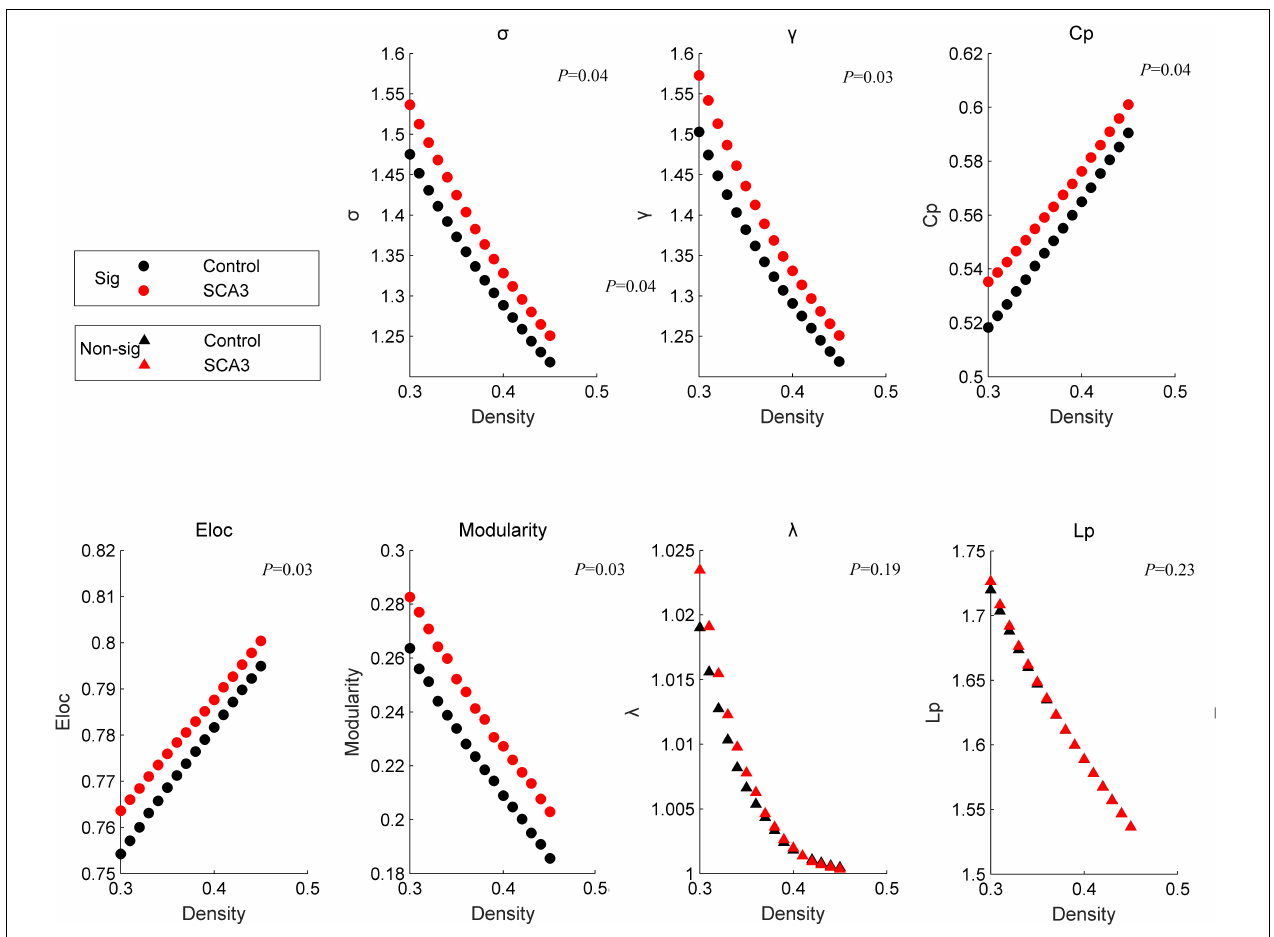
FIGURE 1 | Disrupted graphic topology properties. Dots represent significant differences between the two groups. Triangles represent no significant differences between the two groups. Black/NC represents normal control subjects. Red/SCA3, represents SCA3 patients. σ , small-worldness; C p , clustering coefficient; γ , normalized clustering coefficient; L p , shortest path length; λ , the characteristic path length; E Loc , local efficiency; E glob , global efficiency; T , transitivity; α , assortativity.